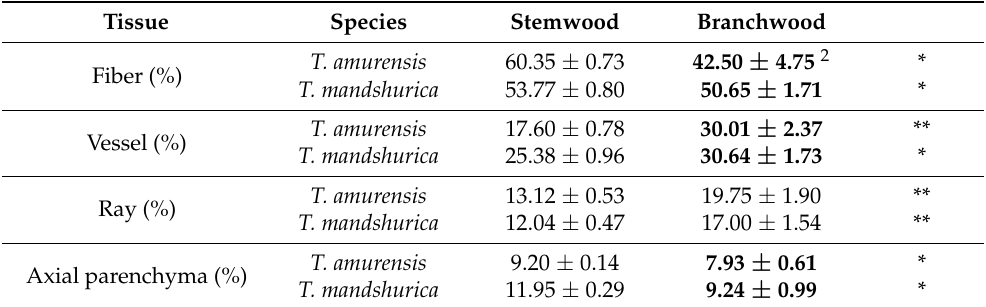
Figure 1. Cross-sections of the stemwood of T. amurensis ( a ) and T. mandshurica ( b ), and of the branchwood of T. amurensis ( c ) and T. mandshurica ( d ): axial parenchyma (P), ray parenchyma (R), vessels (V) and fibers (F). The scale bar represents 200 µ m. Table 2. Comparison of tissue proportions in the branchwood and stemwood from two Tilia species 1 .